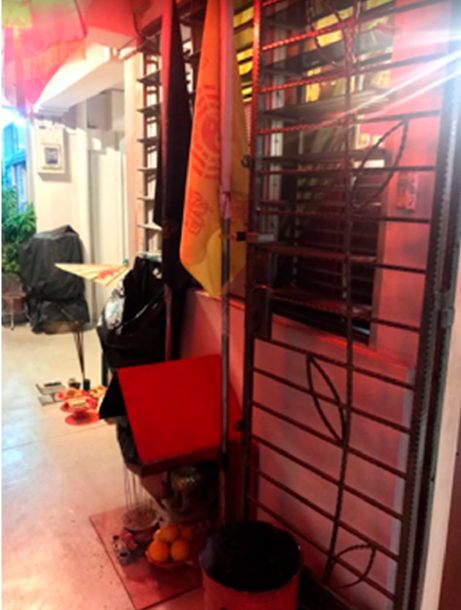
Figure 1. The Outside of a Sintua Housed in a Typical Three-room HDB flat. A black command flag can be seen outside the flat, indicating that a tangki operates within this sintua. The presence of other features, such as the red banner (at the top of the picture), a small altar on the ground, and other religious paraphernalia, may also suggest that a flat is used for religious purposes.